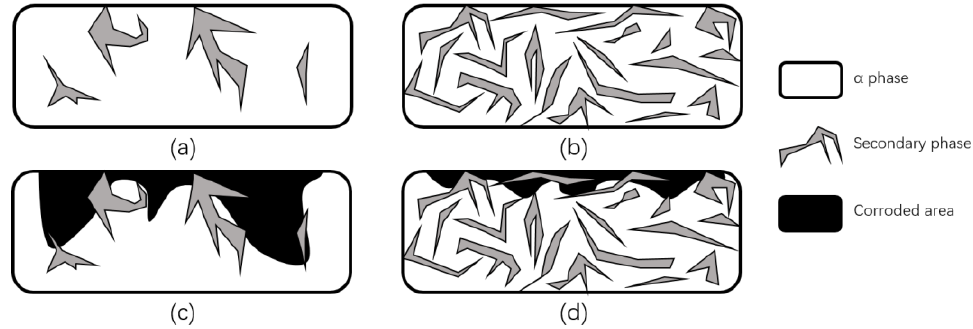
Figure 26. Schematic diagram of corrosion before and after LSM. ( a ) Distribution of a small amount of discontinuous secondary phase in magnesium alloys. ( b ) Distribution of a large number of continuous secondary phases in magnesium alloys. ( c ) Corrosion damage of magnesium alloys containing a small amount of discontinuous secondary phase. ( d ) Corrosion damage of magnesium alloys containing a large number of continuous secondary phases (Adapted with permission from Ref. [101]. 1999, Song,